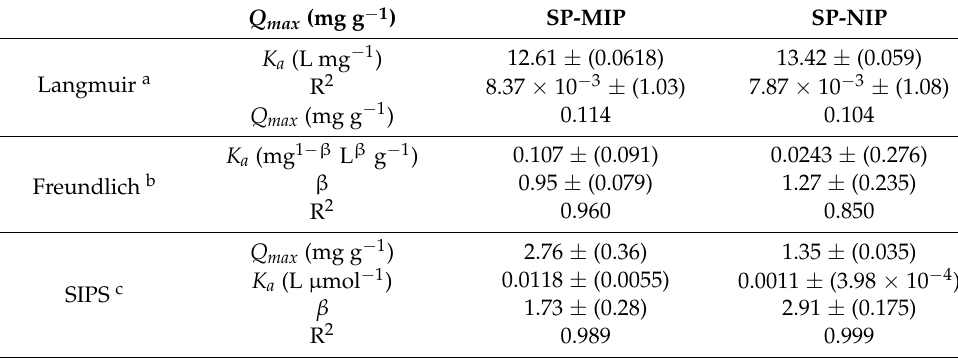
Table 4. Experimental results were based on Linear fitting for the Langmuir, Freundlich, and SIPS isotherm